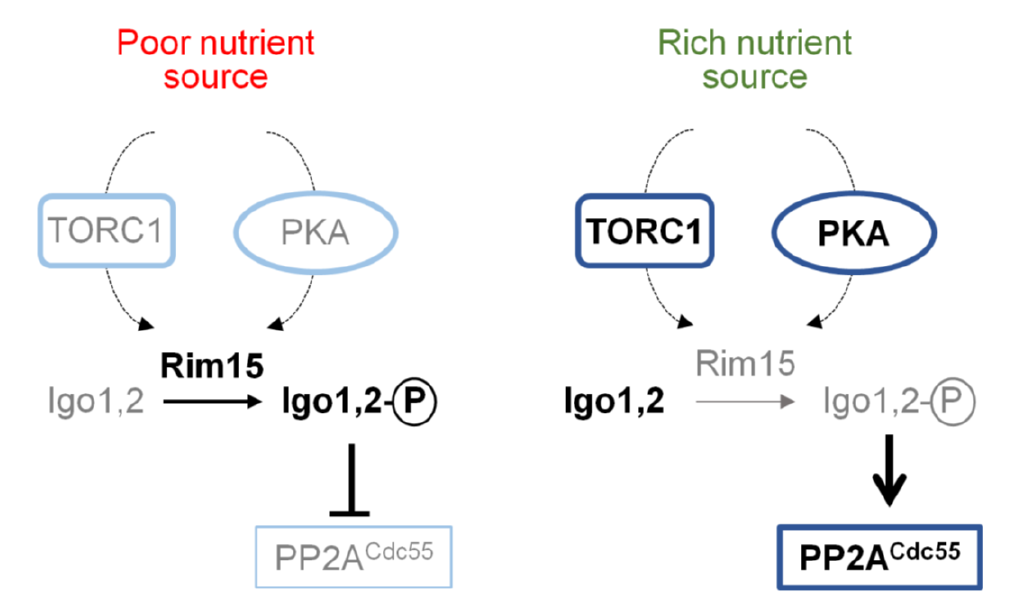
228 Microbial Cell | MAY 2019 | Vol. 6 No. 5